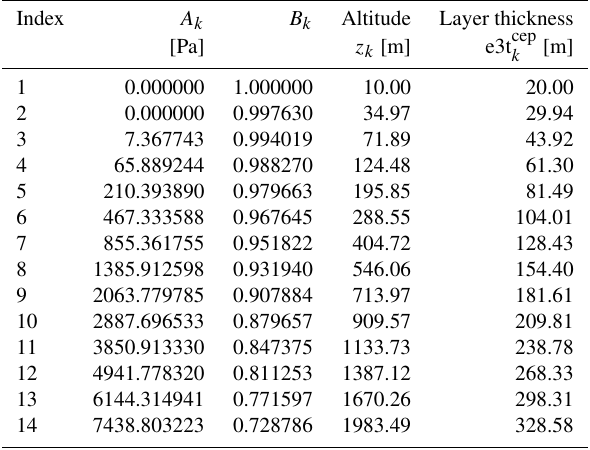
Table B1. Altitude z k and layer thickness e3t k of the IFS L60 verti- cal grid in the first 2000m with respect to the parameter values A k and B k of a surface pressure p s = 1013hPa.